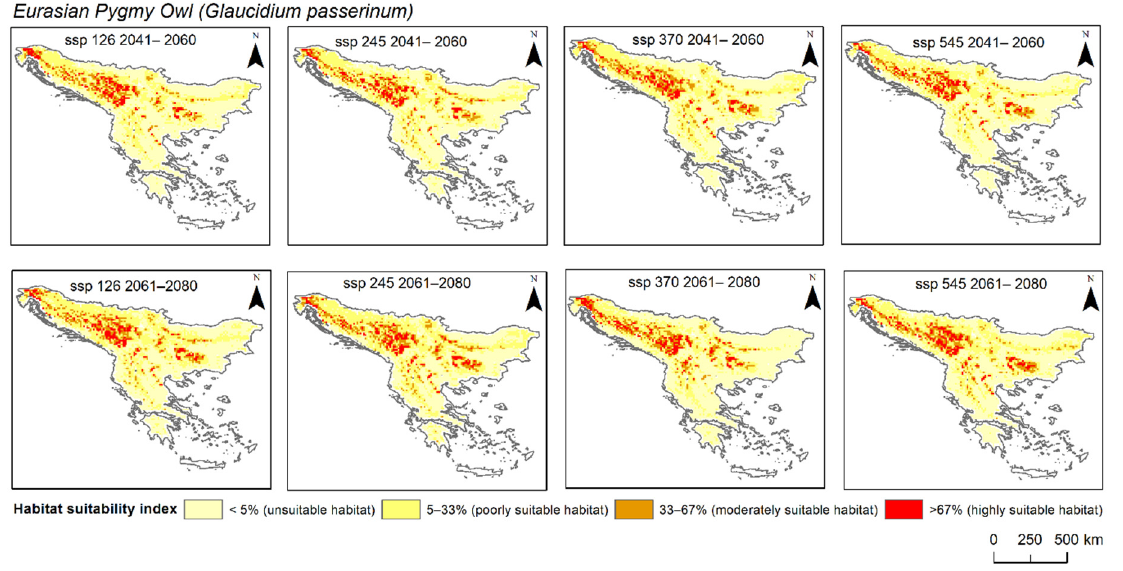
Figure 3. Predicted highly suitable habitat of Eurasian Pygmy Owl ( Glaucidium passerinum ) under projected future climate scenarios (SSP 126, 245, 370, 585) in two different periods: 2041–2060 and 2061–2080. Colour coding: beige = unsuitable habitat; light yellow = poorly suitable habitat; dark yellow = moderately suitable habitat; red = highly suitable habitat).